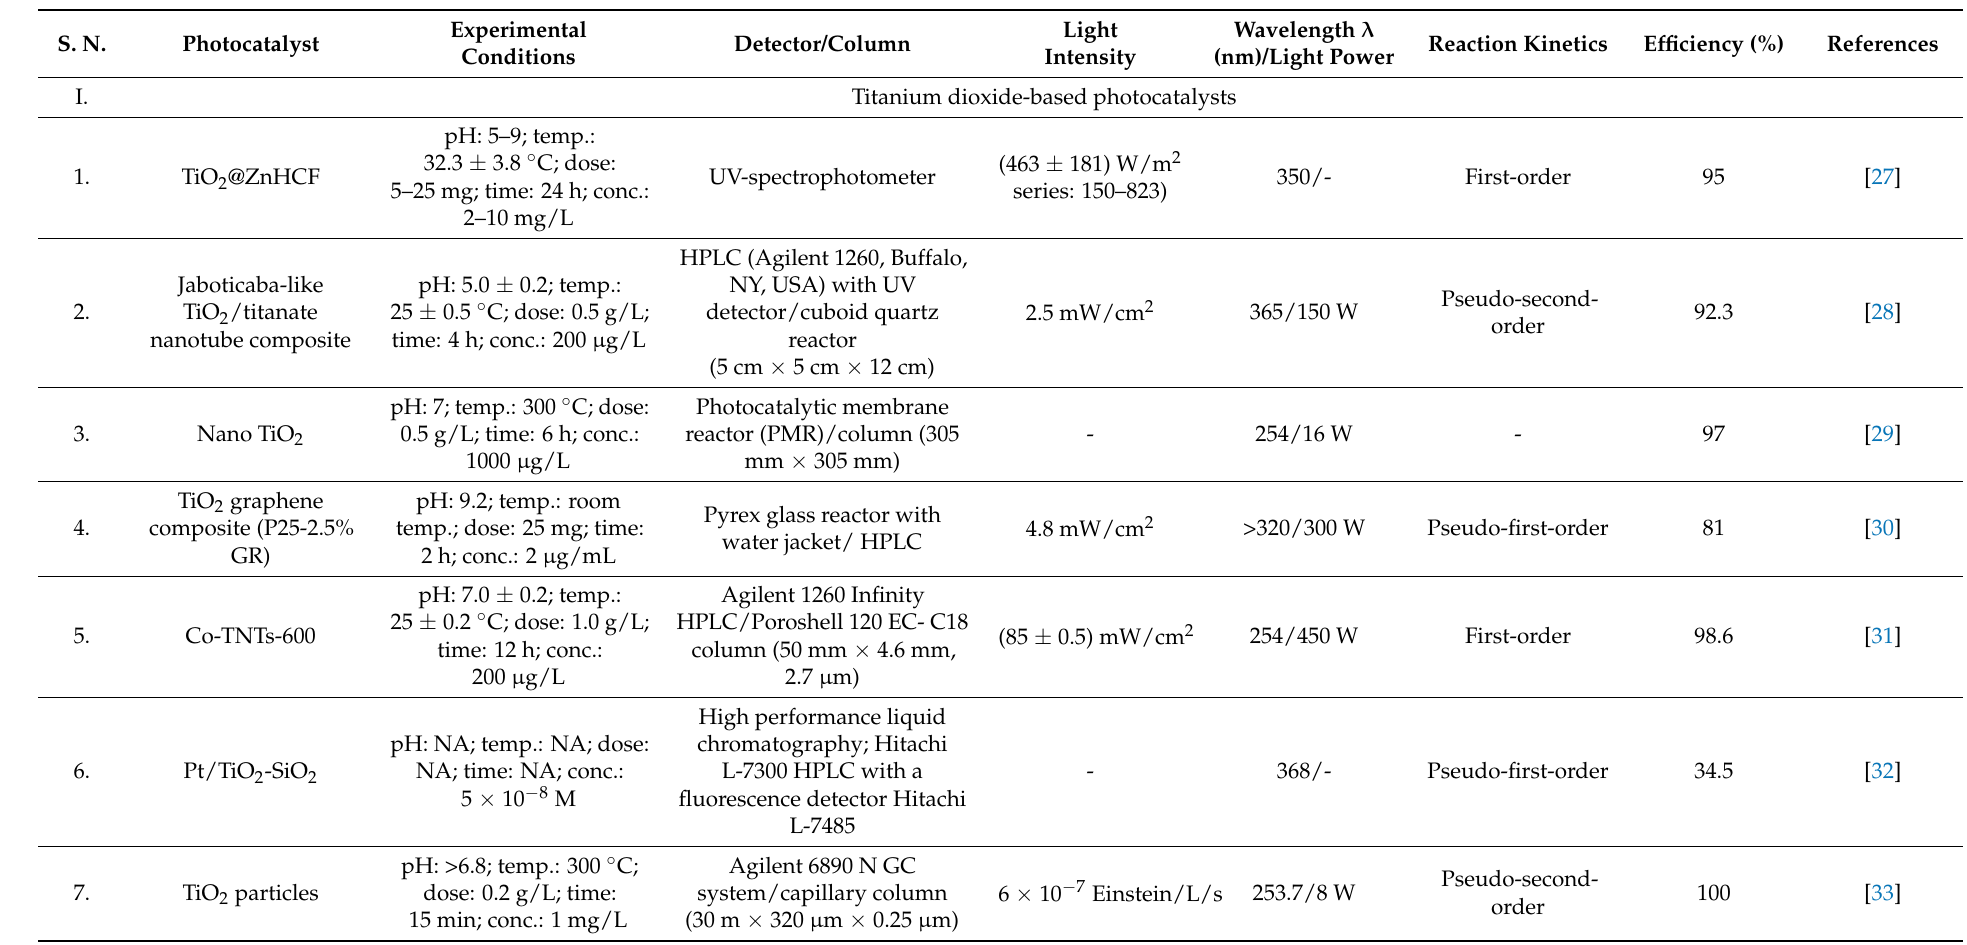
Table 1. List of different photocatalysts and their various parameters for the degradation of phenanthrene. S.